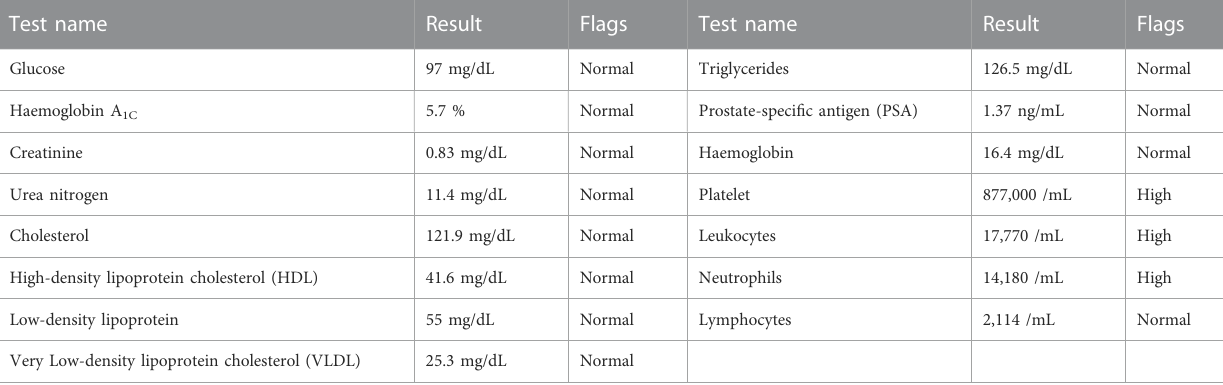
TABLE 2 Clinical Laboratory Report, April